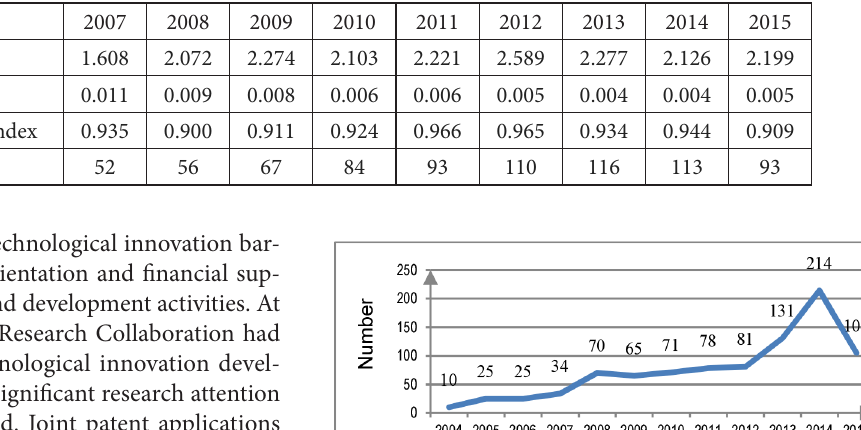
Table 5. The parameter of enterprise-enterprise cooperative network from 2007 to 2015